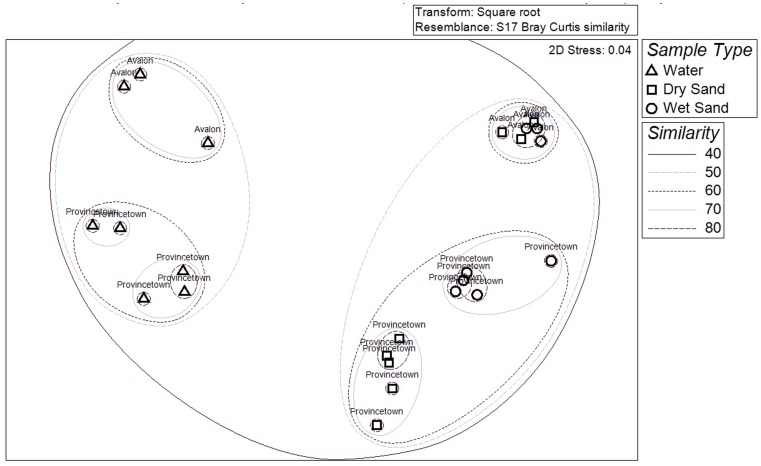
NMDS plot of total bacterial community composition in samples.